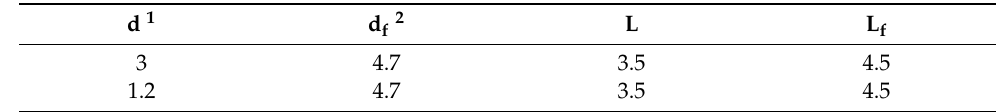
Figure 3. Structure of short orifice. Table 1. Orifice dimensions (mm).